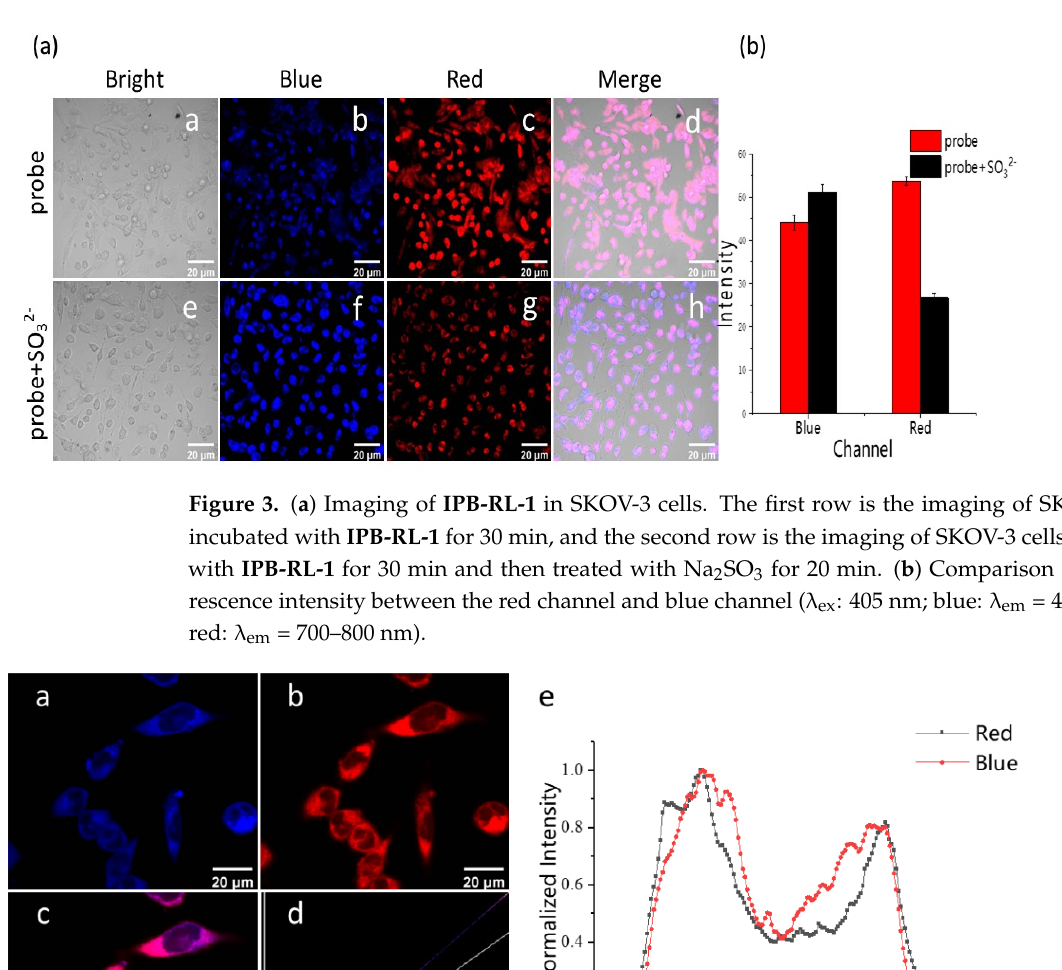
Figure 5. Fluorescence images of IPB-RL-1 in zebrafish (a−d: the control group; e−h: zebrafish incu- bated with IPB-RL-1 only; i −l : zebrafish incubated with IPB-RL-1 for 1 h and then SO 32− for 30 min; λ ex : 405 nm; blue: λ em = 420 − 520 nm; red: λ em = 700 − 800 nm).